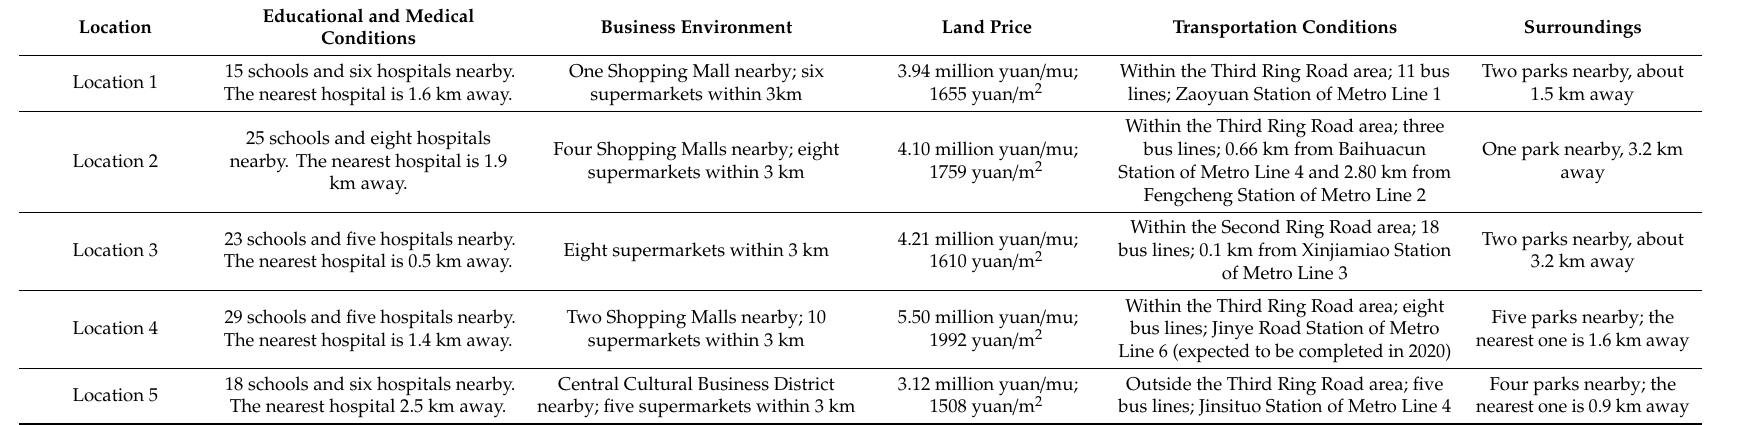
Table 5. Details of each proposed location